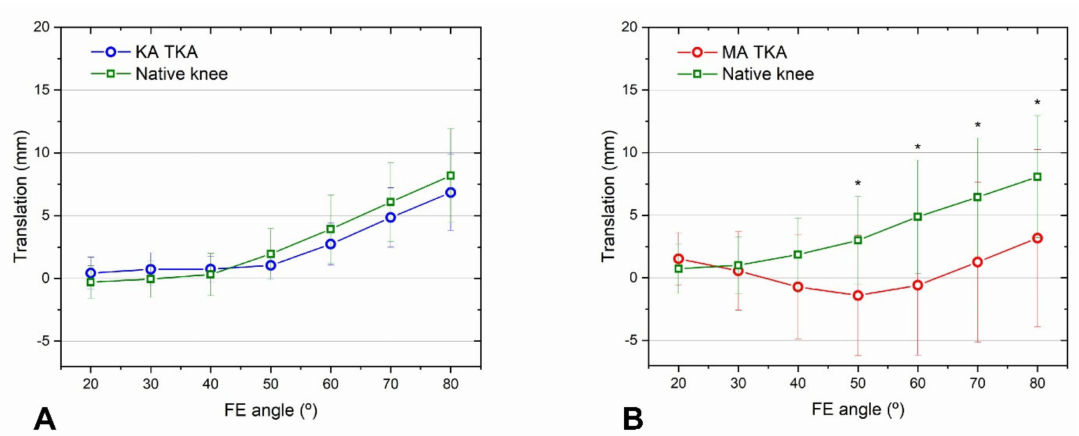
Figure 4. Medial femoral rollback after KA TKA ( A ) and MA TKA ( B ). Rollback following KA TKA and of the native knees were similar at all flexion angles. Meanwhile, rollback following MA TKA was reduced at flexion angles > 40 ◦ . Error bars denote standard deviations. Significant differences ( p < 0.05) are marked with asterisks.